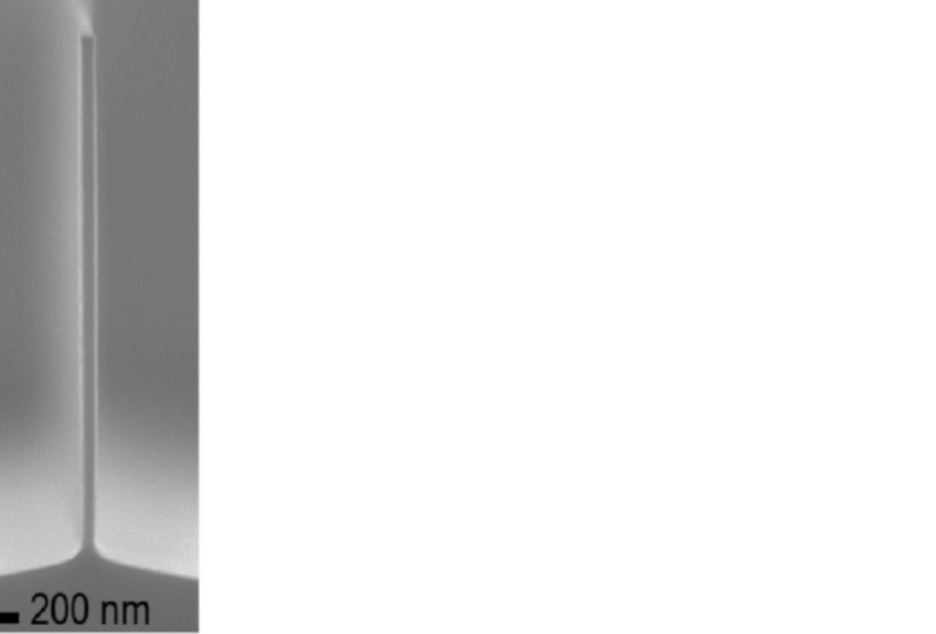
Figure 10. A GaAs nanowaveguide structure after passivation layer has been removed with an aspect ratio of >32, with a N 2 flux of 11.8% ([115], used with permission from the Copyright Center and the contact